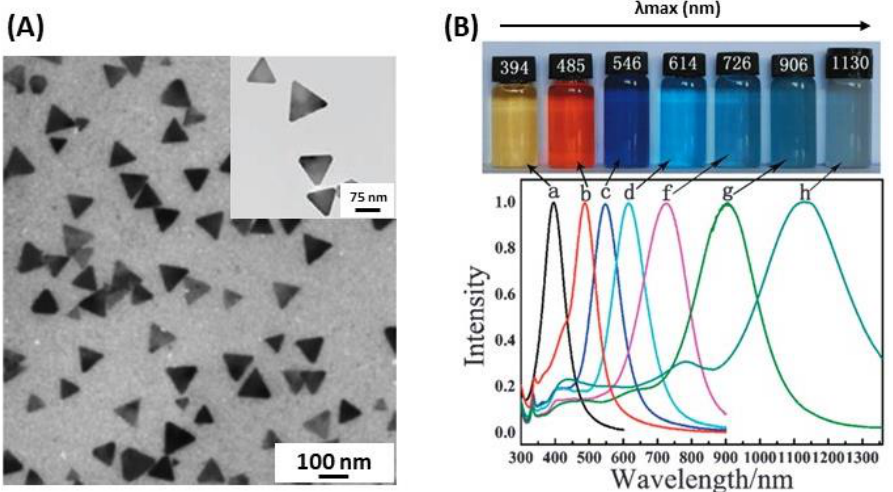
Figure 4. ( A ) TEM image of AgNPls. ( B ) Dispersions of Ag (a) sphere and (b – h) nanoplate colloids with different colors and corresponding UV-vis-NIR extinction spectra that reflect the ability to tune the plasmon resonance of the nanoplates across the visible near-infrared (NIR) portion of the spectrum (500 – 1100 nm). The nanoplate optical resonance and size are tuned according to different seed growth. Adapted from [90,93]. Copyright (2008, 2013), Royal Society of rounds of Ag seed growth. Adapted from [90,93]. Copyright (2008, 2013), Royal Society of Chemistry.